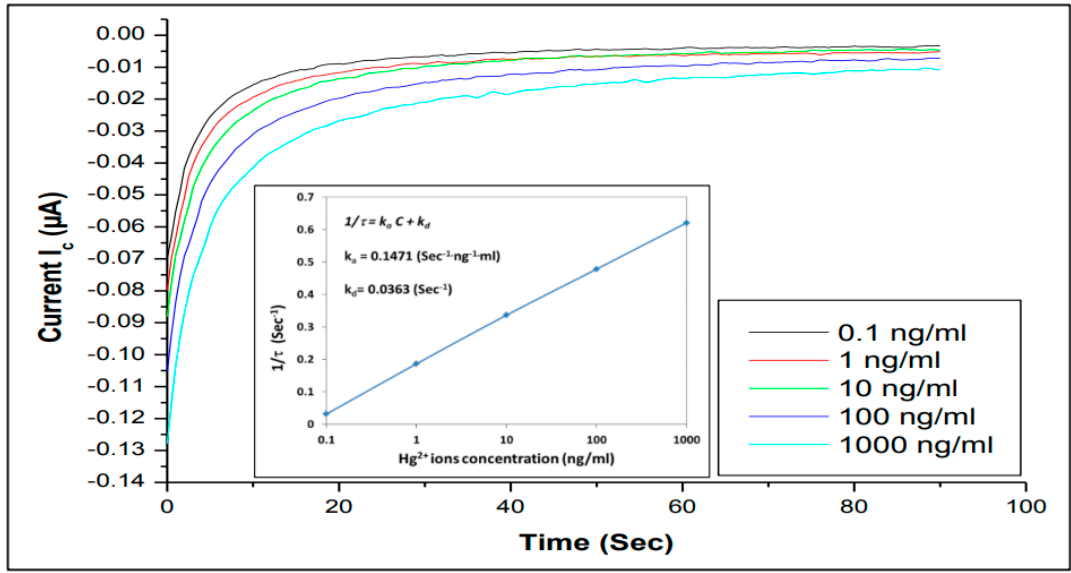
Figure 7. Time dependencies of the cathode current at fixed voltage of − 0.2 V for different concentrations of different concentrations Hg 2+ binding to anti-Hg 2+ aptamer. The inset shows the dependence of 1/ τ against the concentration of Hg 2+ ions.